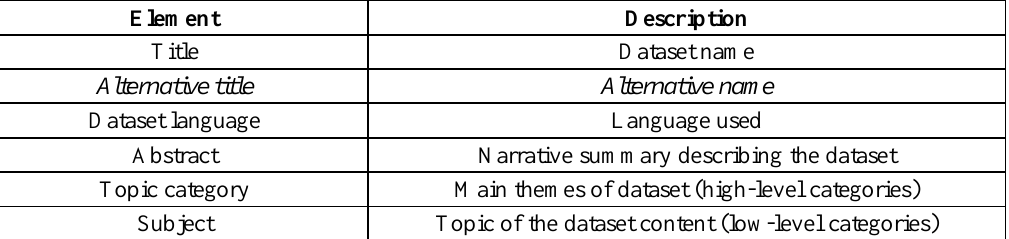
Table 1. The UK GEMINI 32 metadata element set - optional elements in